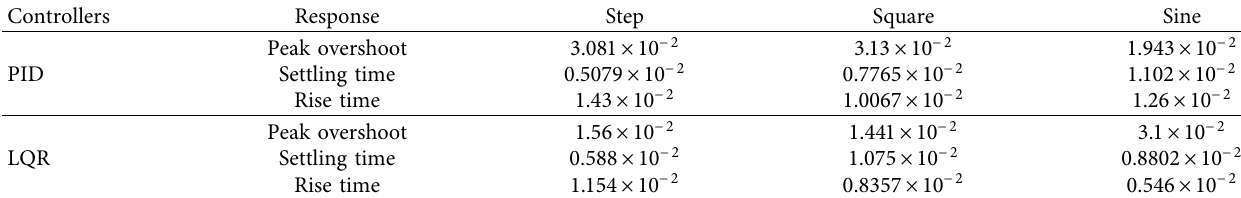
Table 4: Response of the magnetic levitation system with PID and LQR controllers. Controllers